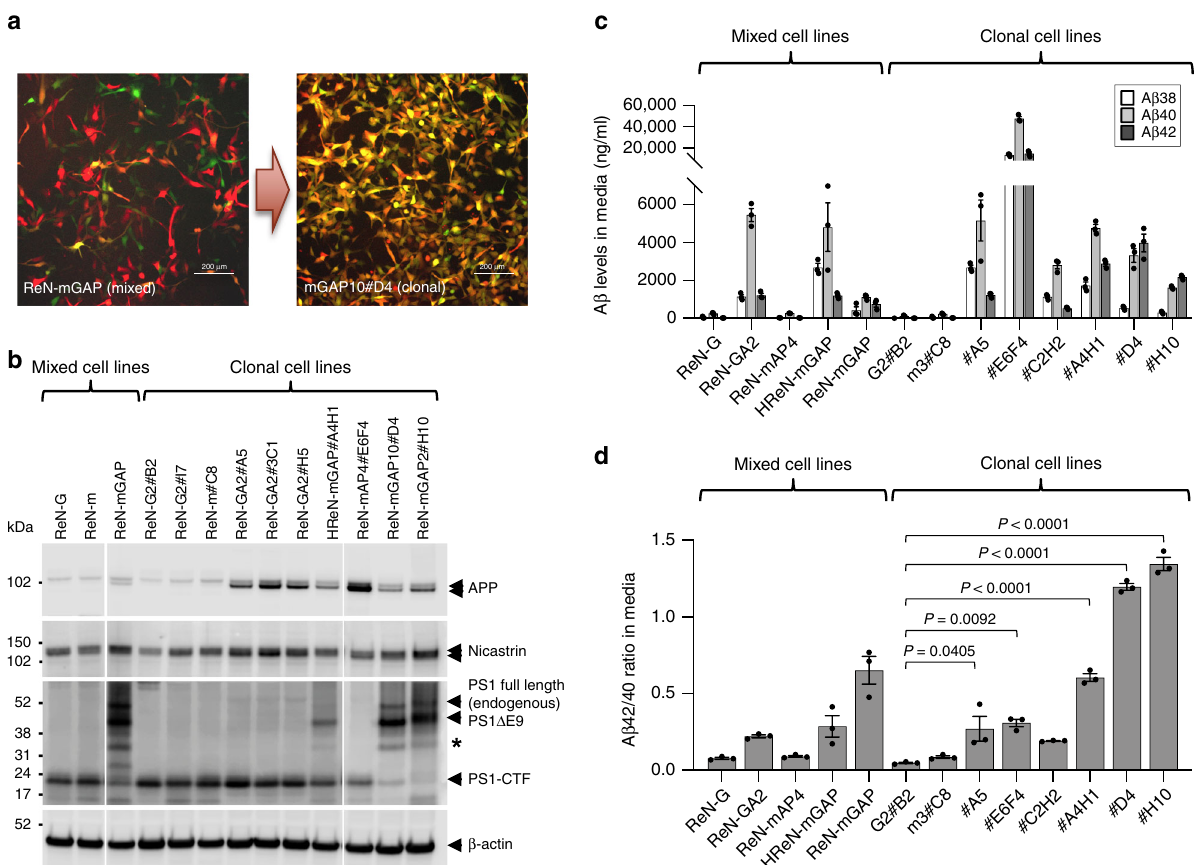
Fig. 2 Clonal FAD hNPCs produce high levels of A β with different A β 42/40 ratio. a Representative confocal images of ReN-mGAP (mixed) and ReN- mGAP10#D4 (clonal) cells. 2D-cultured cells were expanded on glass-bottom dishes. Cells were imaged with GFP and mCherry which represent APPSL and PS1 Δ E9, respectively, using confocal microscopy. Scale bars represent 200 μ m. b Expression of APP and PS1 Δ E9 in clonal hNPCs. Cells were prepared in 6-well plates and grown for 24 h. Expression levels of APP and PS1 Δ E9 were monitored by Western blot analysis. Levels of nicastrin and PS1-CTF were also monitored. β -Actin was used as a loading control. Asterisk represents a nonspeci fi c band. c Comparison of A β 38, A β 40 and A β 42 levels between mixed and clonal hNPC lines. Indicated mixed and clonal cells (3 × 10 6 ) were grown in Matrigel-coated 6-well plates for 24 h. After changing media with 1 ml of fresh expansion media, cells were incubated for an additional 24 h. Conditioned media was analyzed by MSD A β assay to measure concentrations of secreted A β species. d A β 42/40 ratios were determined. All values were combined to express as mean ± SEM of three independent repeats (black dots). Statistical signi fi cances were determined by one-way ANOVA with Tukey ’ s multiple comparisons